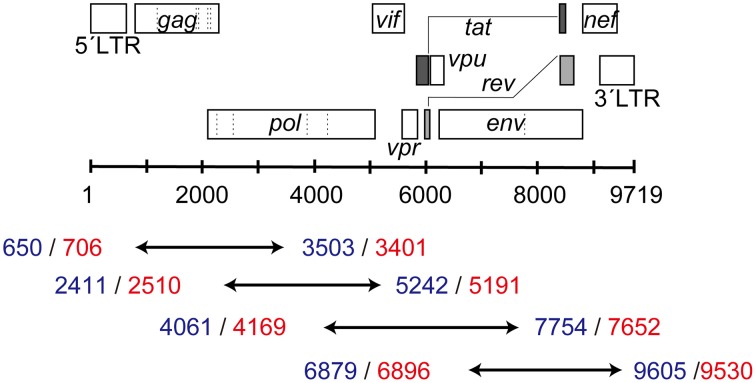
Four overlapping segments covering the HIV-1 near-full-length genome. The blue numbers represent the 5′- and 3′-end positions (HXB2 numbering) for RT-PCR, whereas red numbers show those for nested PCR.